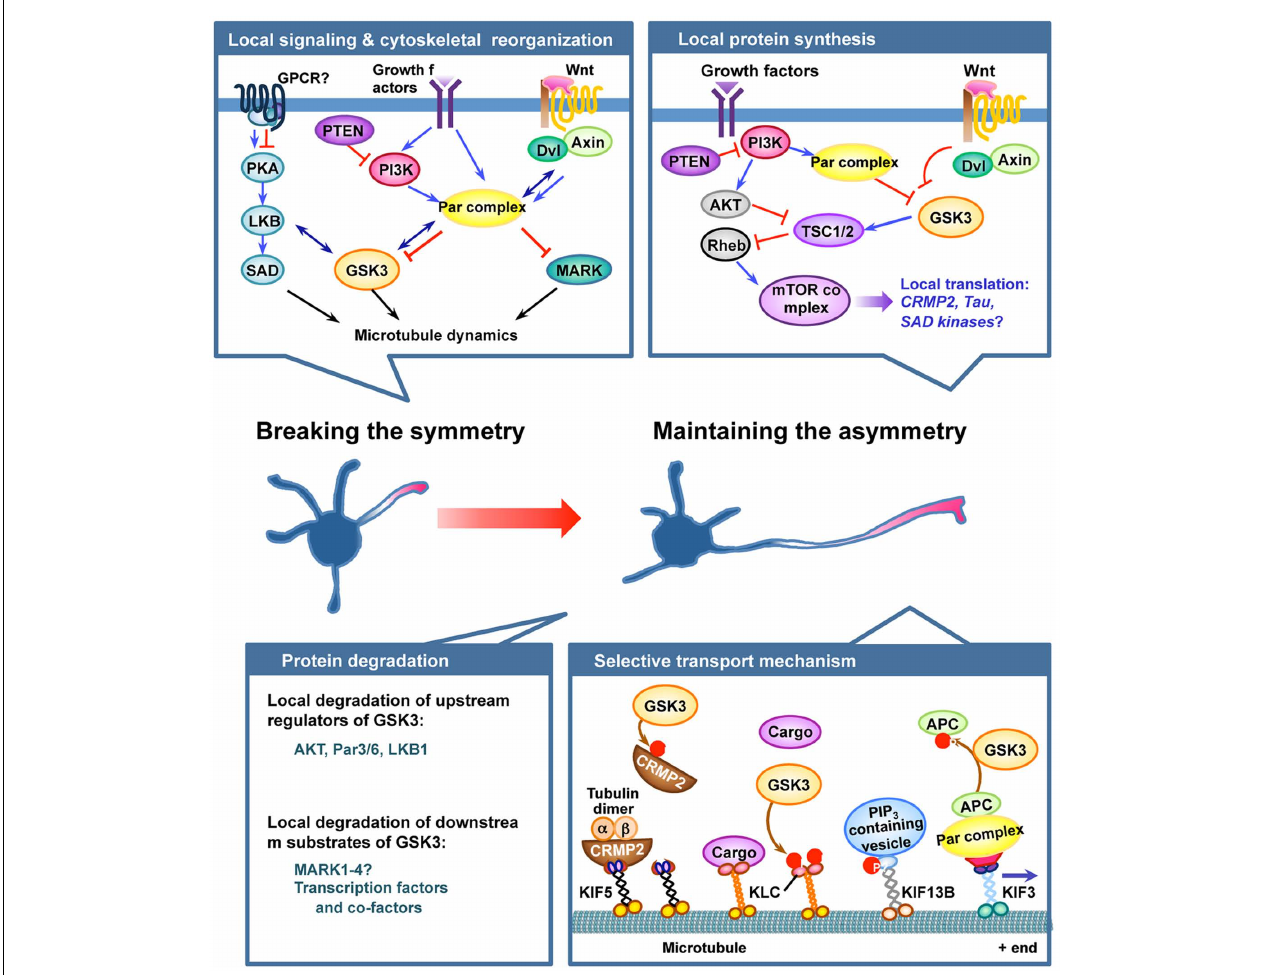
GSK3 has been implicated in the local protein synthesis pathway by controlling the activity of the mammalian target of rapamycin (mTOR) complex via phosphorylating tuberous sclerosis 2 (TSC2), but the exact roles of the players involved and their regulation in the context of axon growth await to be determined. Local protein degradation through activation of the ubiquitin–proteasome system (UPS) is another possible mechanism to maintain asymmetrical accumulation of polarity proteins. Molecules that control GSK3 activity, such as Akt, PAR3/6, and LKB1, have been suggested as targets of the local degradation process. In addition, accumulating evidence suggests that protein levels of multiple downstream substrates of GSK3 are controlled by phosphorylation-dependent proteolytic degradation. Future studies are required to determine whether GSK3 activation in dendrites plays a part in maintaining the polarized growth of the axon and restricting the growth of the dendrites by controlling local protein degradation. Finally, selective delivery of membrane and cytoskeletal components and signaling proteins into defined compartments is an important mechanism to maintain neuronal polarity. GSK3 phosphorylates several motor proteins and polarity proteins to control their selective transport and localization. See text for further details for each of the mechanism depicted in the